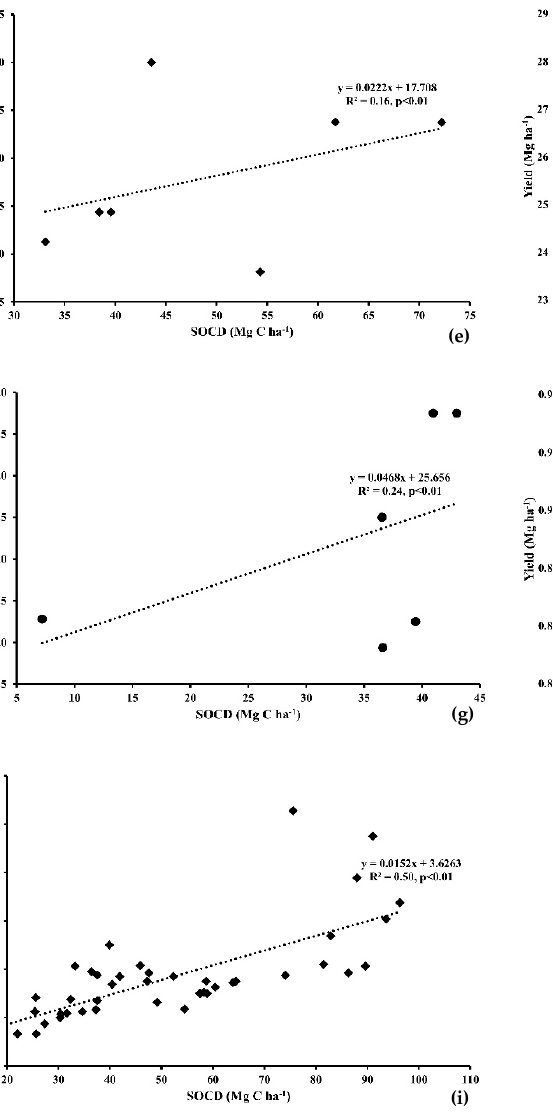
Figure 5. Relationship between SOCD and crop yields: ( a ) cabbage; ( b ) upland rice; ( c ) lowland rice; ( d ) tomato; ( e ) strawberry; ( f ) potato; ( g ) Japanese pumpkin; ( h ) cape gooseberry; ( i ) maize.